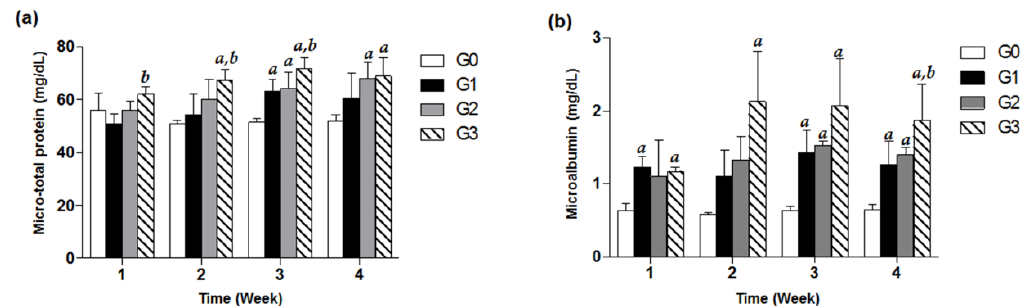
Figure 2. Effects of TDF on urine micro-total protein and microalbumin in mice. Forty-eight mice were divided into four groups, and each group (G0–G3) contained 12 mice. Each of the three treatment groups consisted of 12 mice: G1 group (TDF 200 mg/kg/d, p.o .), G2 group (TDF 500 mg/kg/d, p.o .), and G3 group (TDF 800 mg/kg/d, p.o .). Urinary micro-total protein ( a ) and microalbumin ( b ) levels of each